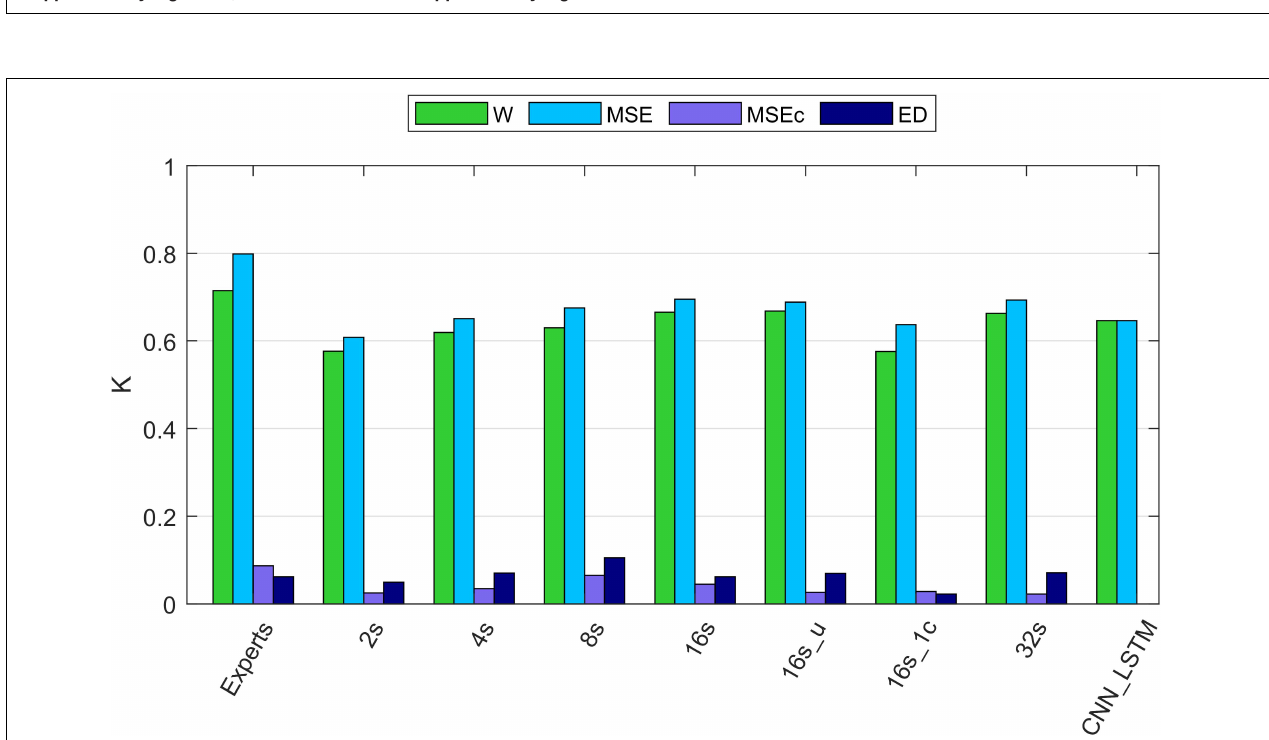
FIGURE 4 | Cohen’s kappa of different algorithms along with the agreement between two experts. W, wakefulness; MSE, microsleep episodes; MSEc, microsleep candidates; ED, episodes of drowsiness. Experts: agreement between two experts computed based on five recordings containing MSEs. 2–16s: comparison between one expert and convolutional neural networks (CNNs) with window lengths 2, 4, 8, and 16 s. 16s_u: CNN with a 16s window and uniformly weighted classes. 16s_1c: CNN with 16s window and only one EEG channel as input. 32s: CNN with a 32s window. CNN_LSTM: CNN combined with a long-short term memory (LSTM) architecture; it has only two classes because this network was trained to detect only MSEs, everything else was considered as wakefulness. If not mentioned otherwise, one occipital EEG channel and two ocular channels served as input for the networks. Kappa of the neural networks was computed using the validation dataset (12 recordings). The data of all recordings were concatenated to estimate the overall kappa.